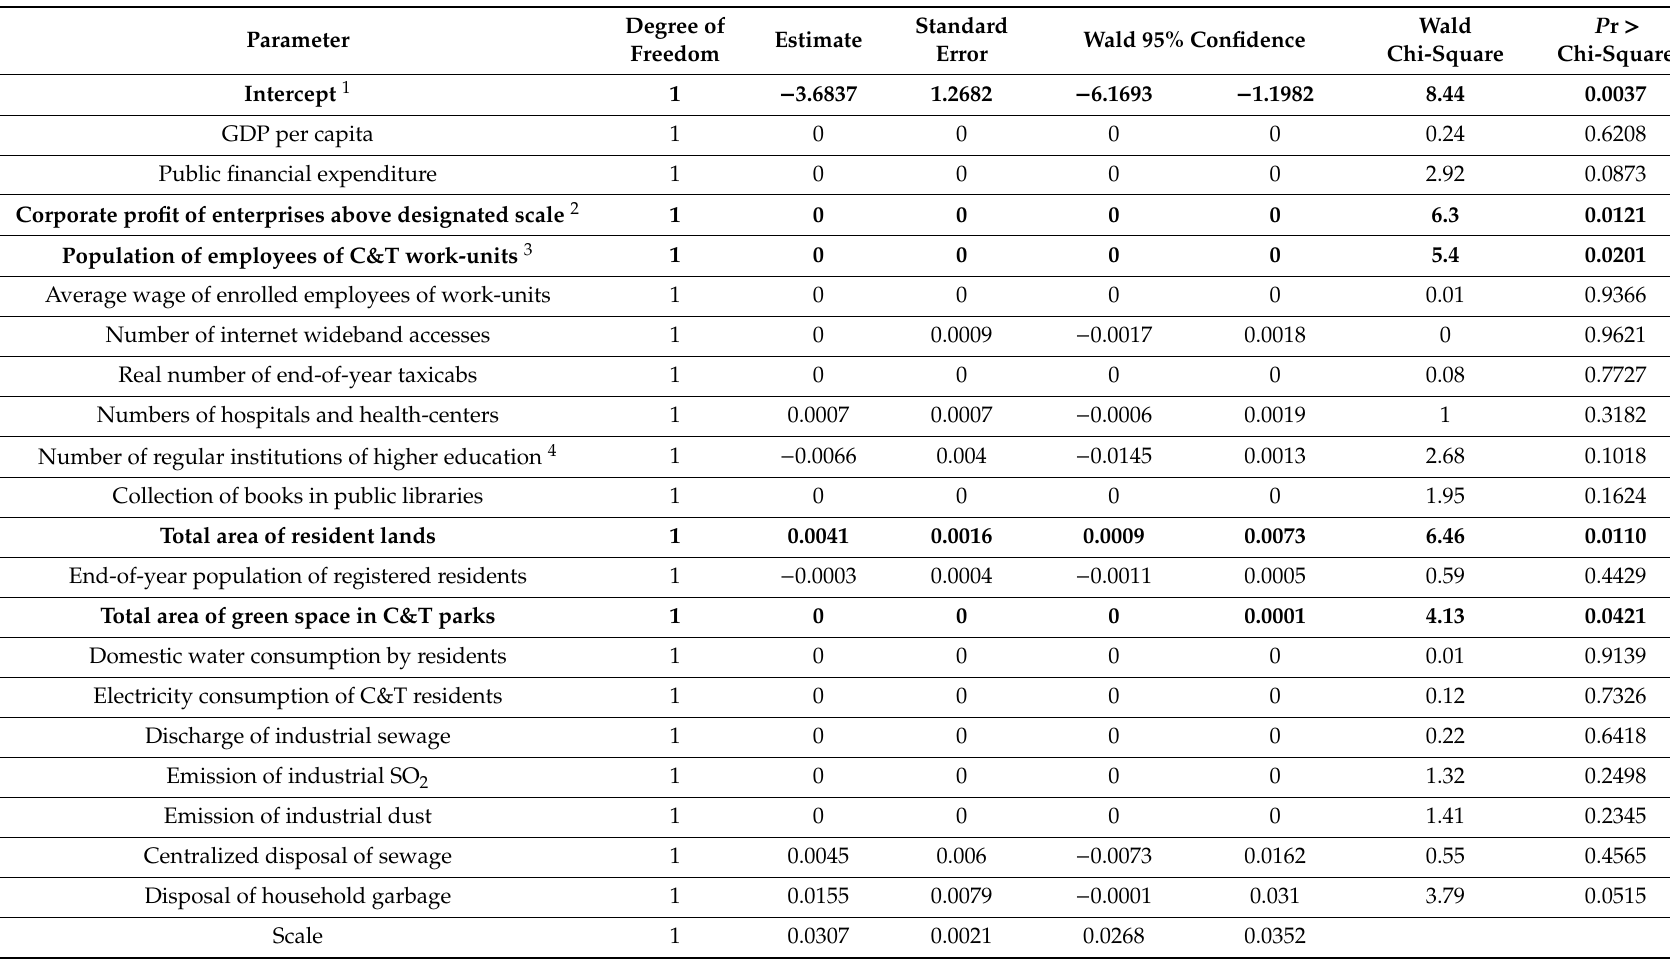
Table 5. Maximum likelihood estimation of multiple city variables on sad expression scores of students from key universities of cities across mainland of